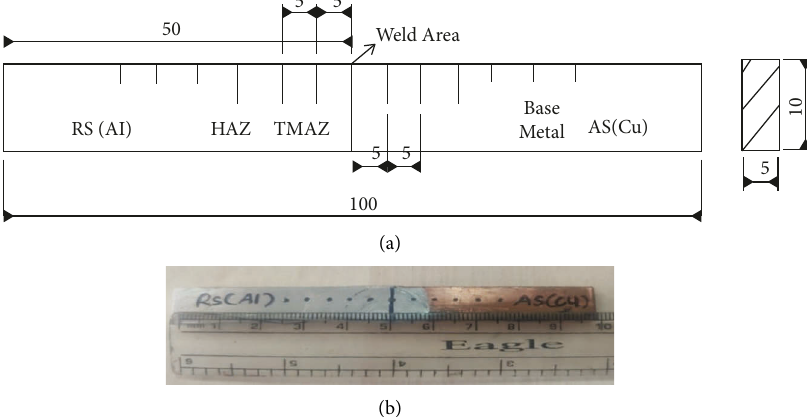
Figure 6: (a) Procedure for microindentation and (b) Sample preparation for microindentation.